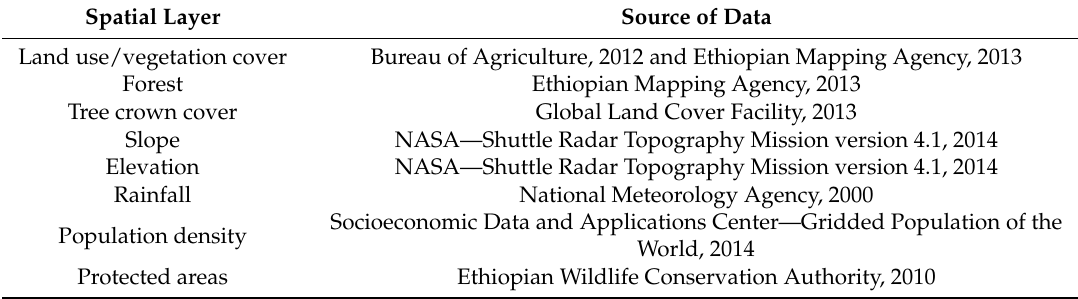
Table 1. Spatial data used for mapping locations and scales of Forest Landscape Restoration (FLR)